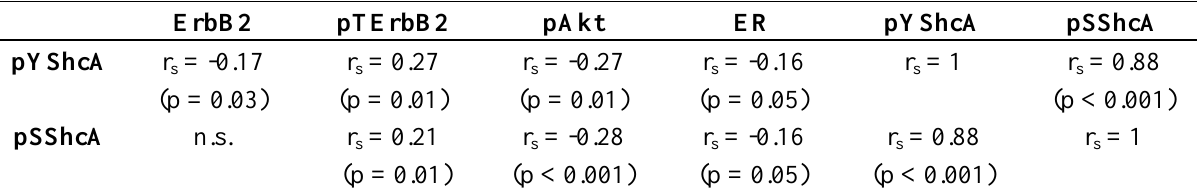
Table 1. Spearman rank correlations of quantitative pShcA and of other biomarkers expression levels. ErbB2 pTErbB2 pAkt ER pYShcA pSShcA